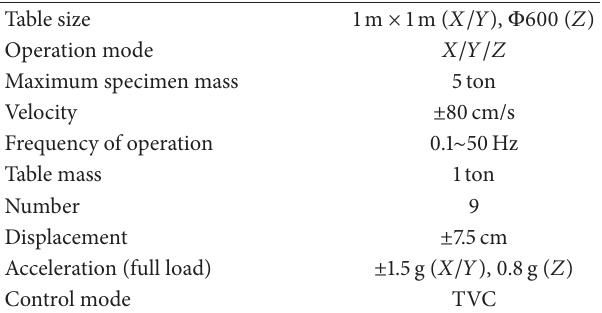
Table 2: Specifications of shake table array in BJUT. Table size